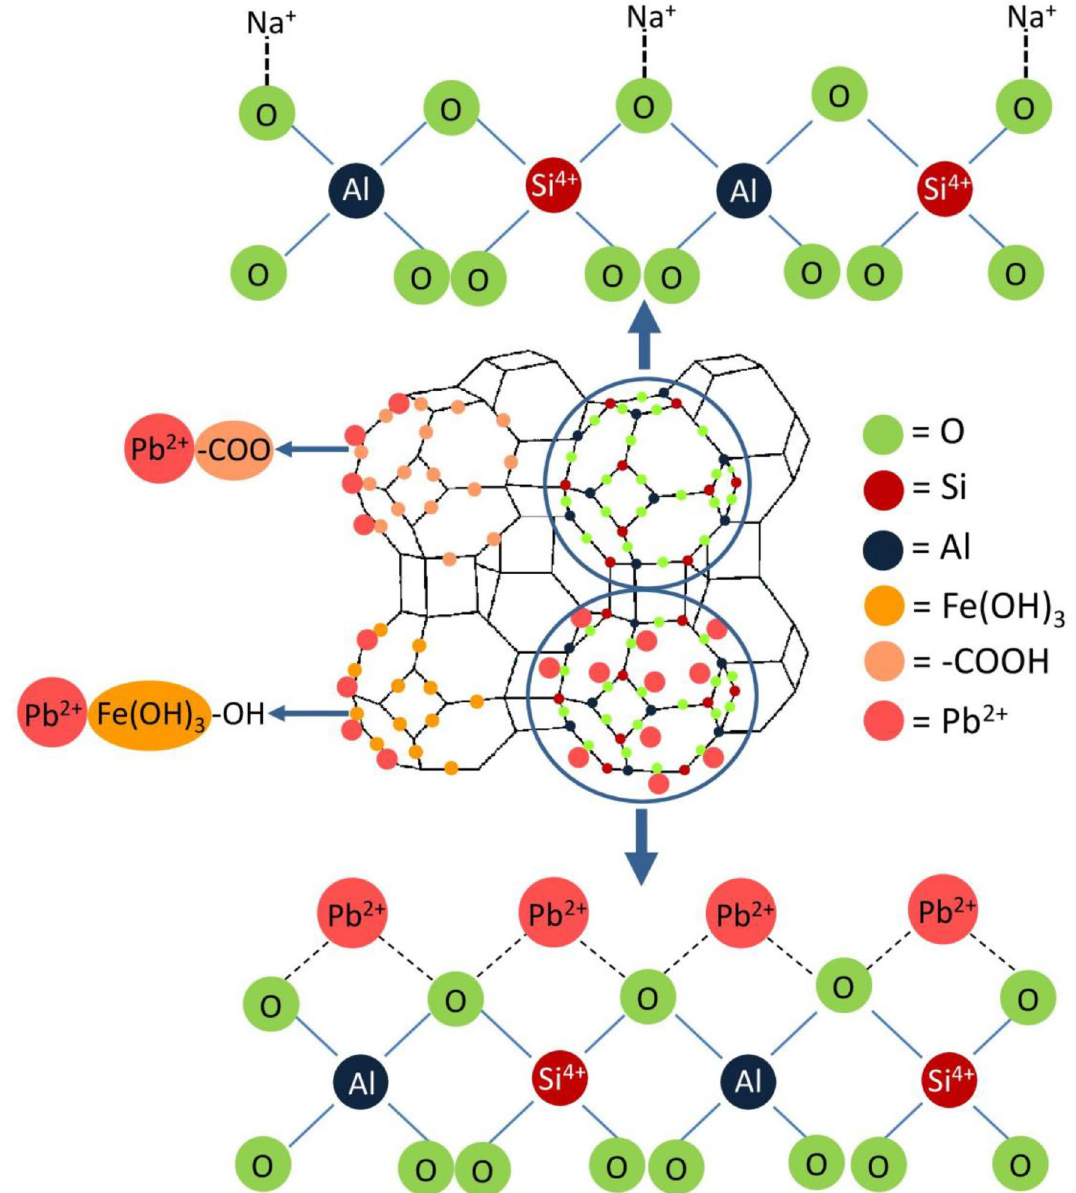
Figure 10. The possible mechanisms for lead adsorption by zeolite A